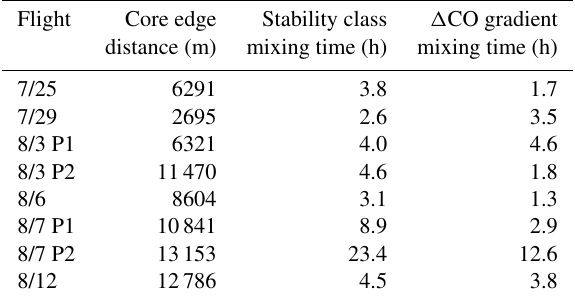
Table 2. The distance between the average location of the 90– 100 (cid:49) CO percentile (core) and the innermost location in the 5–15 percentile bin (edge) and the corresponding time it takes for the plume to mix that